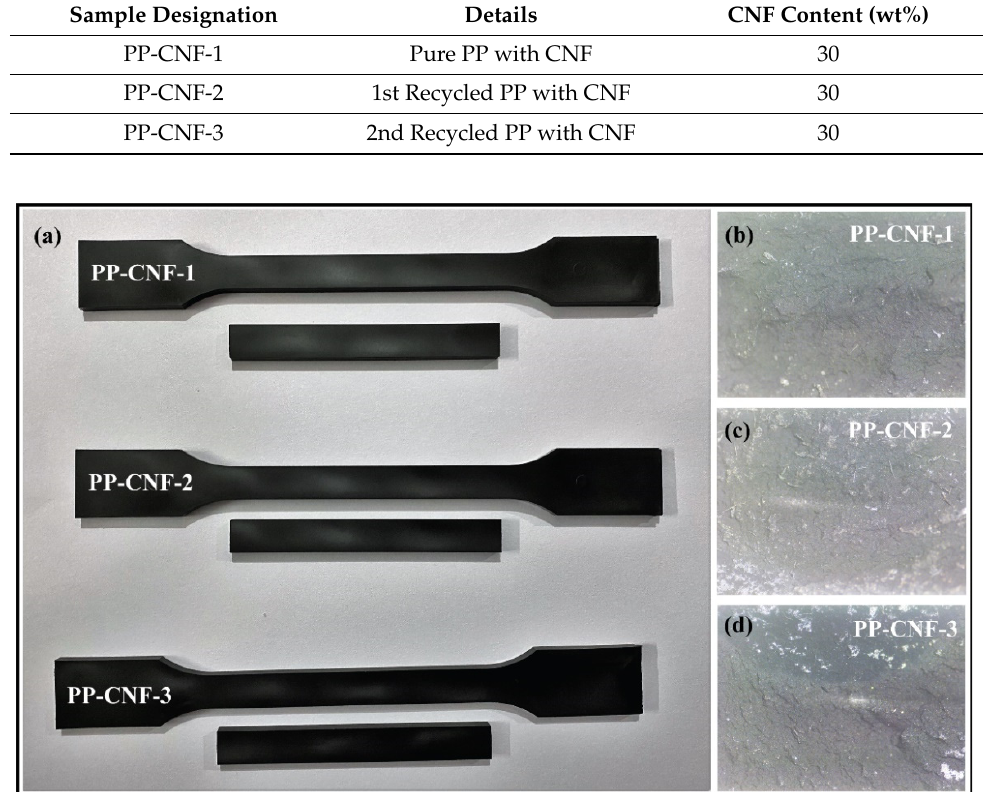
Figure 1. ( a ) Digital image of PP-CNF nanocomposite samples prepared for bending and tensile testing shows no manufacturing defect, and optical images of fractured cross-section show the defect-free surface of ( b ) PP-CNF-1, ( c ) PP-CNF-2, and ( d ) PP-CNF-3.